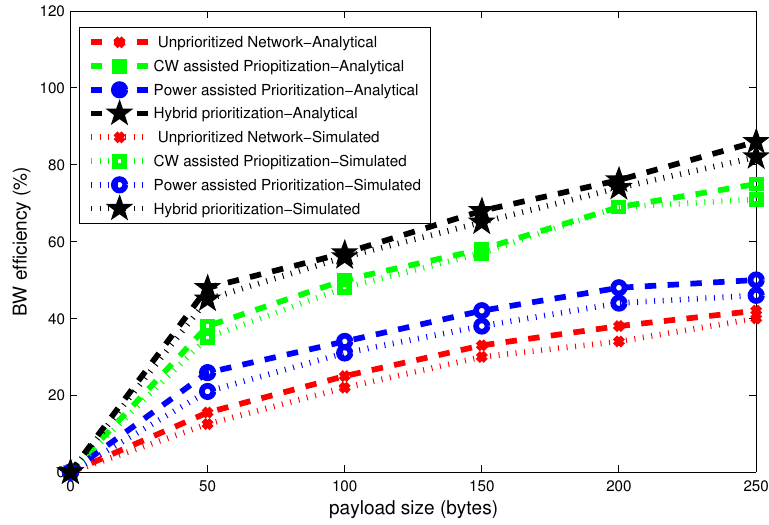
Figure 13. Effect of payload size on bandwidth efficiency.